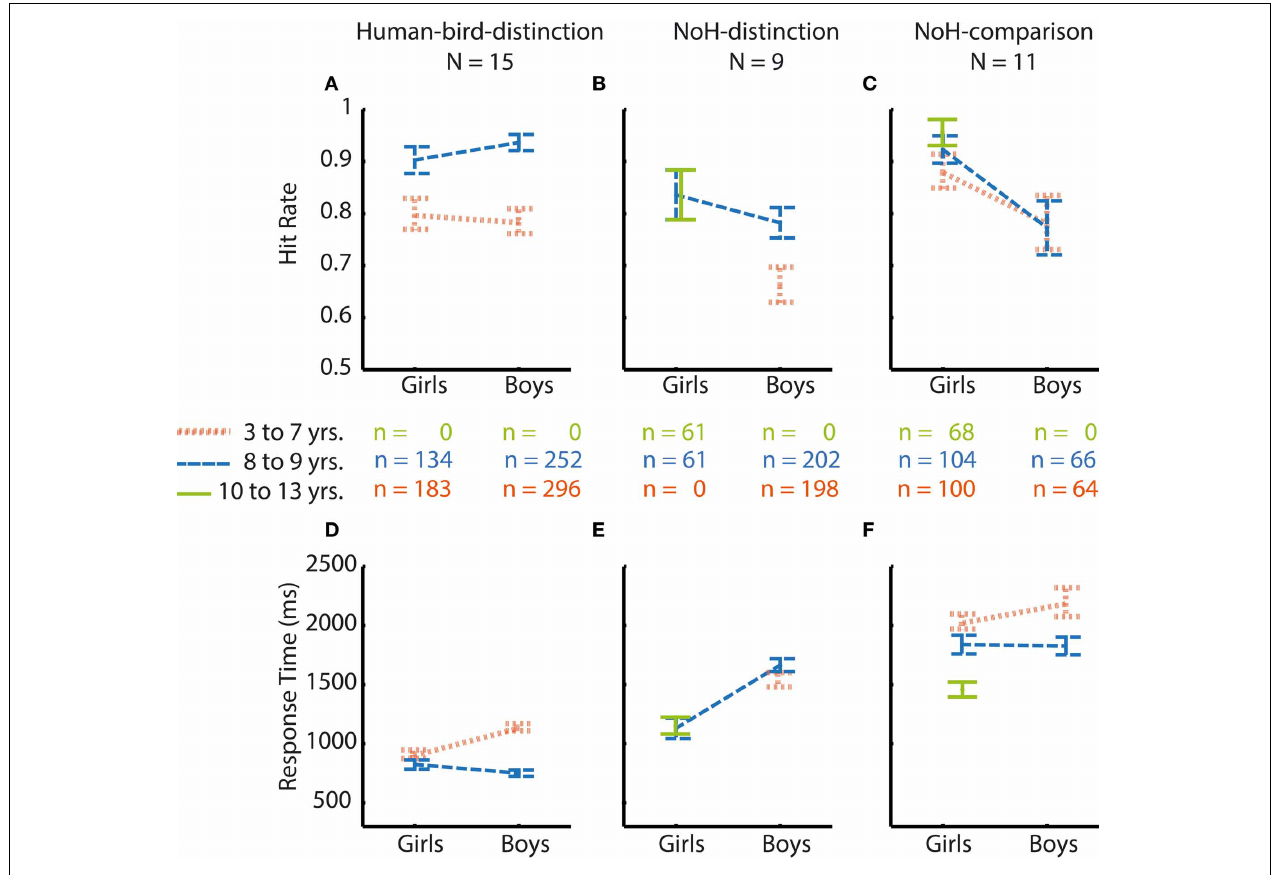
FIGURE 5 | HitratesandRTsforthosechildrenonlycompletingoneortwo paradigms. Data is shown according to age group (youngest = orange thinly dashedlines,middle = bluebroadlydashedlines,oldest = greensolidlines)and gender for all paradigms. Girls’ responses are shown on the left side of each